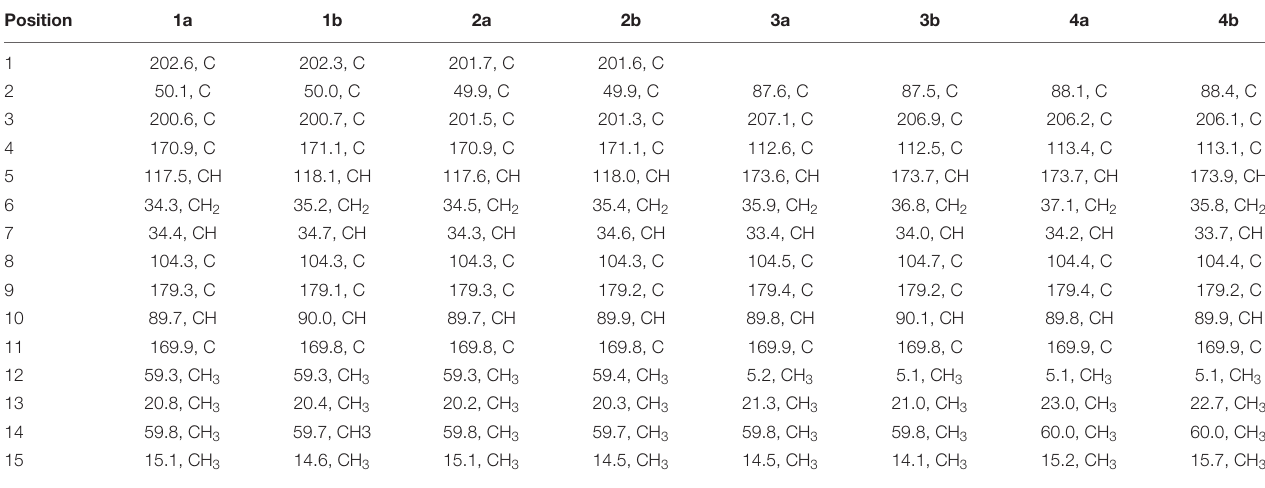
TABLE 2 | 13 C NMR Data (125 MHz, DMSO- d 6 , δ in ppm) for